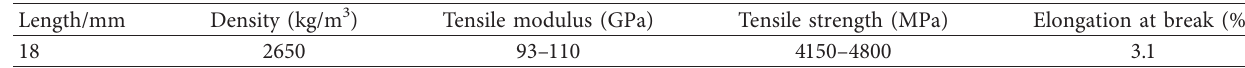
Table 2: Physical and mechanical properties of basalt fiber.